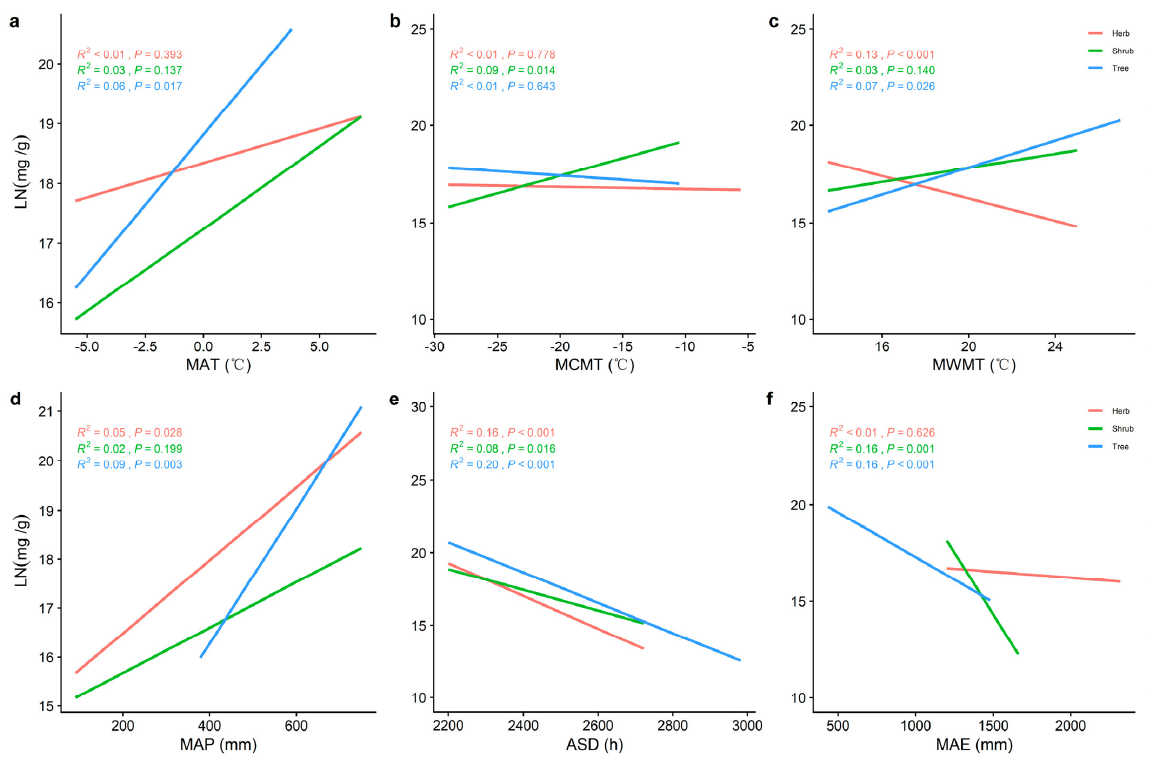
Figure 3. The general linear correlation analysis of climate factors with LN at different life forms. ( a ) General linear relationship between the MAT and LN of plants in the trees, shrubs, and herbs. ( b ) General linear relationship between the MCMT and LN of plants in the trees, shrubs, and herbs. ( c ) General linear relationship between the MWMT and LN of plants in the trees, shrubs, and herbs ( d ) General linear relationship between the MAP and LN of plants in the trees, shrubs, and herbs ( e ) General linear relationship between the ASD and LN of plants in the trees, shrubs, and herbs ( f ) General linear relationship between the MAE and LN of plants in the trees, shrubs, and herbs. MAT represents the mean annual temperature, MCMT represents the mean coldest monthly temperature, MWMT represents the mean warmest monthly temperature, MAP represents the mean annual pre- cipitation, ASD represents the annual sunlight duration, and MAE represents the mean annual evaporation. The red line represents the tree level, the green line is the shrub level, and the blue line is the herb level. R 2 represents how well the model fits the variables studied and the P − value rep- resents the significance level.